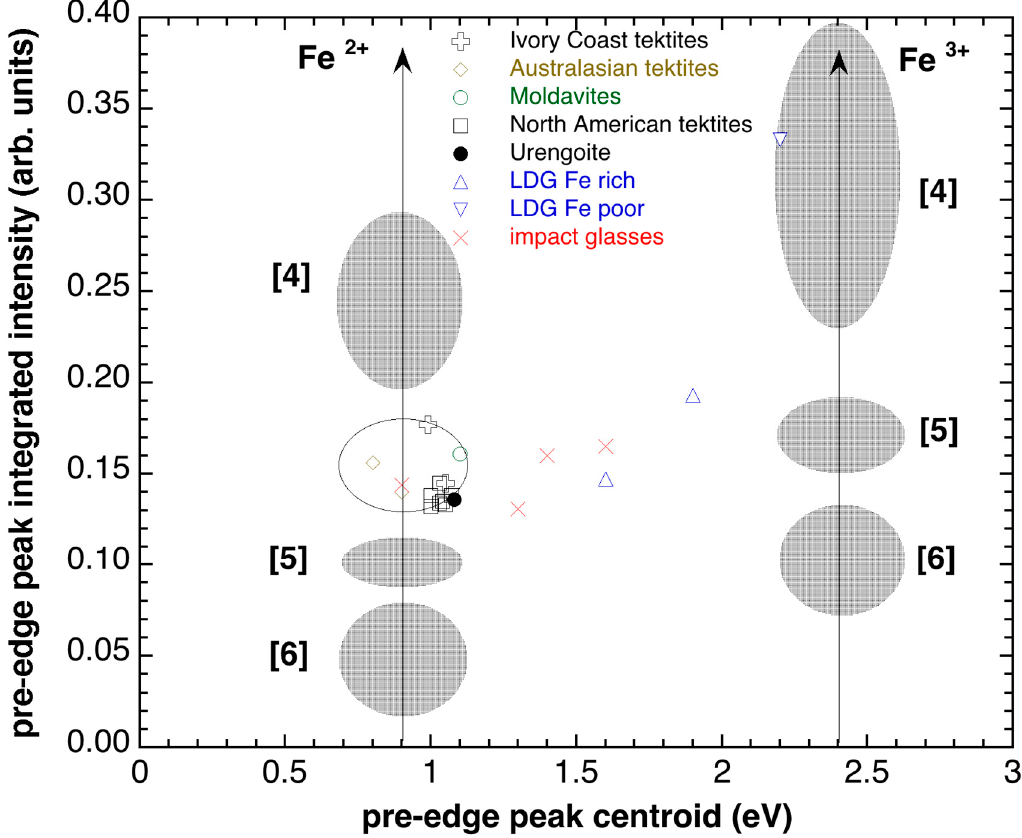
Figure 9. Fe-K-edge pre-edge peak data for urengoite compared to tektites, Darwin glass, LDG, and irghizite (after [27,29,30,45]. All the tektites fall in a narrow range of centroid energies and pre-edge peak integrated area, which indicates the presence of Fe 2 + with average coordination numbers intermediate between 4 and 5. On the other hand, impact glasses span a wide range of Fe oxidation state from dominantly divalent (like in Wabar glasses) to dominantly trivalent (like in Fe-poor Libyan desert glass).